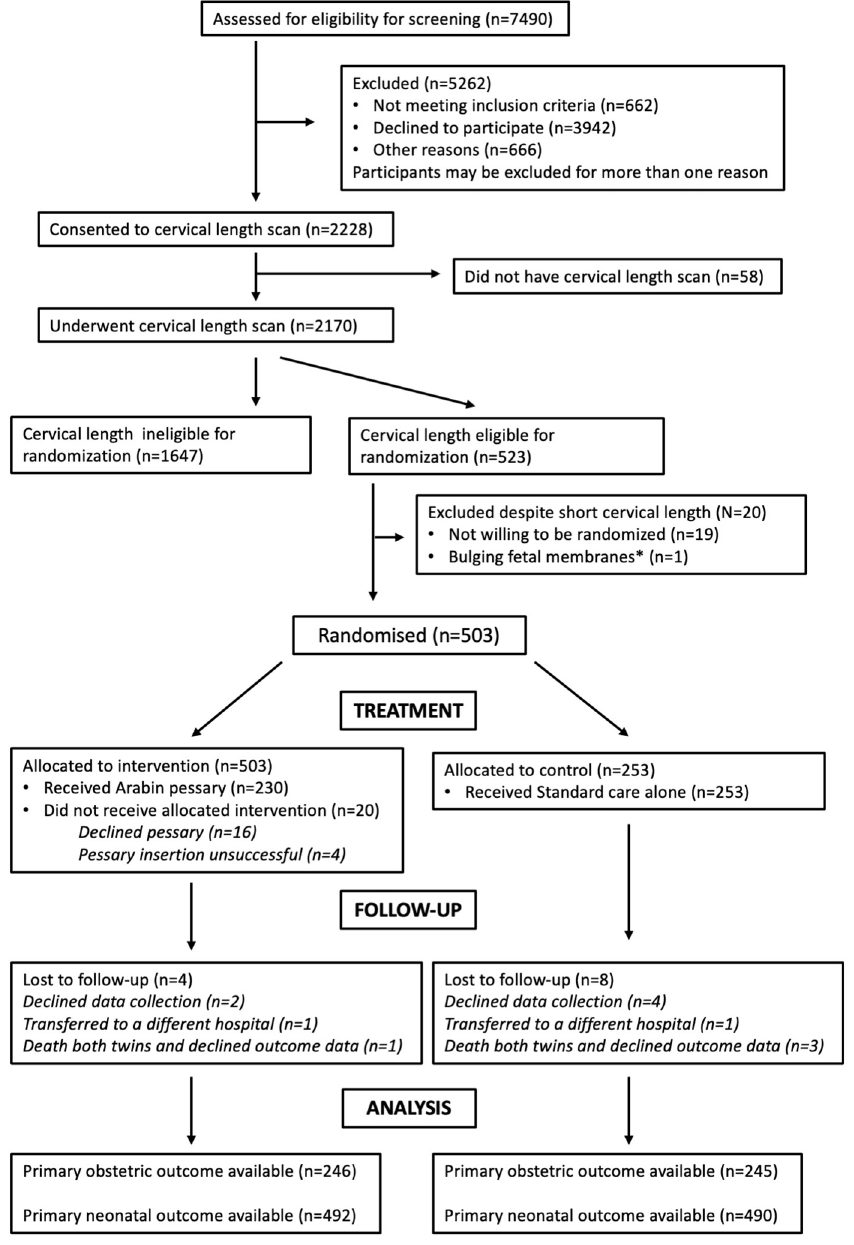
Fig 1 AU : ThereisanasteriskinFig 1 ð after } Bulgingfetalmembranes } Þ butnofootnotetomatch : Pleaseaddtheappropriatefootnotetothefigurelegend ; ordeletetheasteriskfromthefigure : . Participant flowchart. � Bulging fetal membranes noted de novo since qualifying cervical length scan.